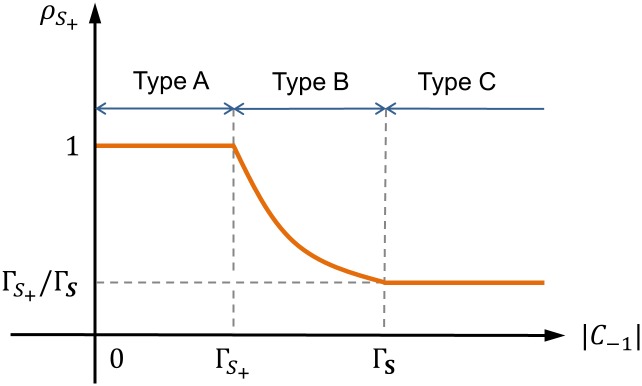
Trading volume ratio (TVR) in a normal coalition B ∪ S
+.